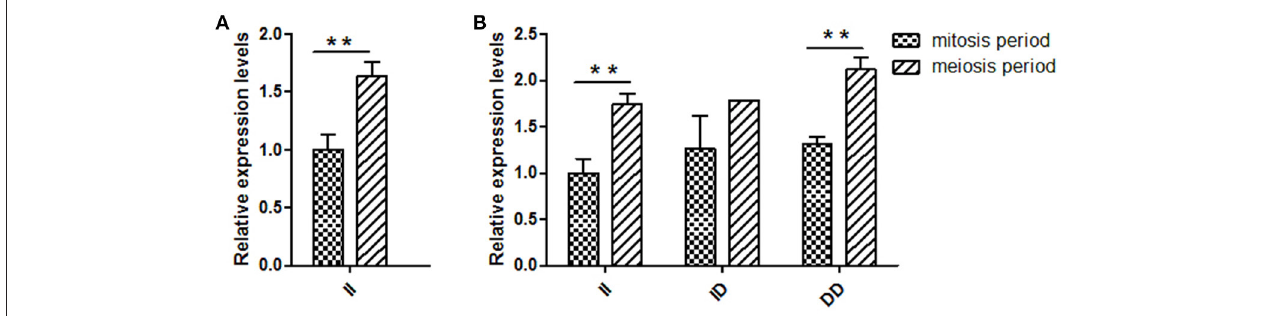
FIGURE 4 | Two indel loci influence KDM6A mRNA expression between two periods. (A) In the 16 bp locus, KDM6A expression levels were significantly higher in the meiosis period of the II genotype. (B) In the 5 bp locus, the II and DD genotype had a significantly difference between two periods. Data represent means ± SE. ** P < 0.01.